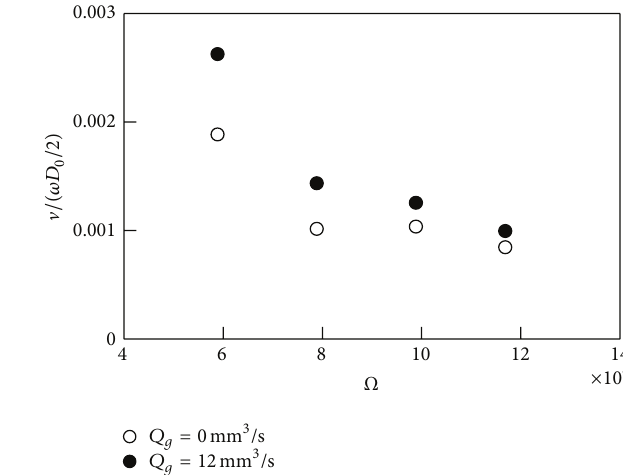
Figure 19: Precessional speed for the upper end of vortex